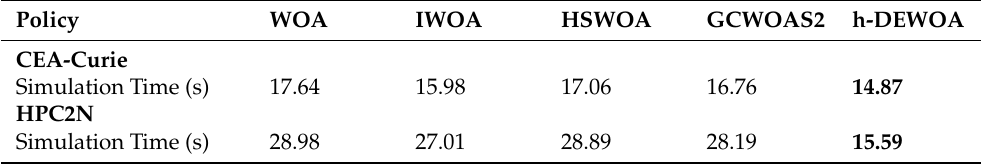
Table 20. Mean simulation time of scheduling algorithms for the first series of